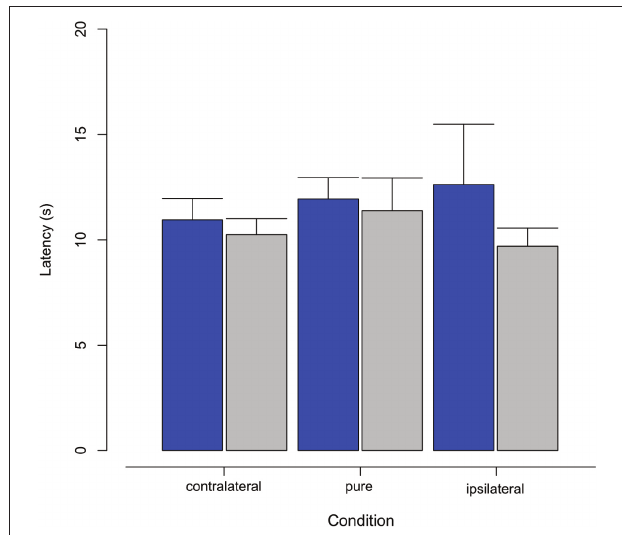
FIGURE 3 | Means and standard errors for vection onset latencies obtained in each of the three radial flow display conditions (contralateral, pure, ipsilateral) with either active (blue) or passive (gray) viewing.